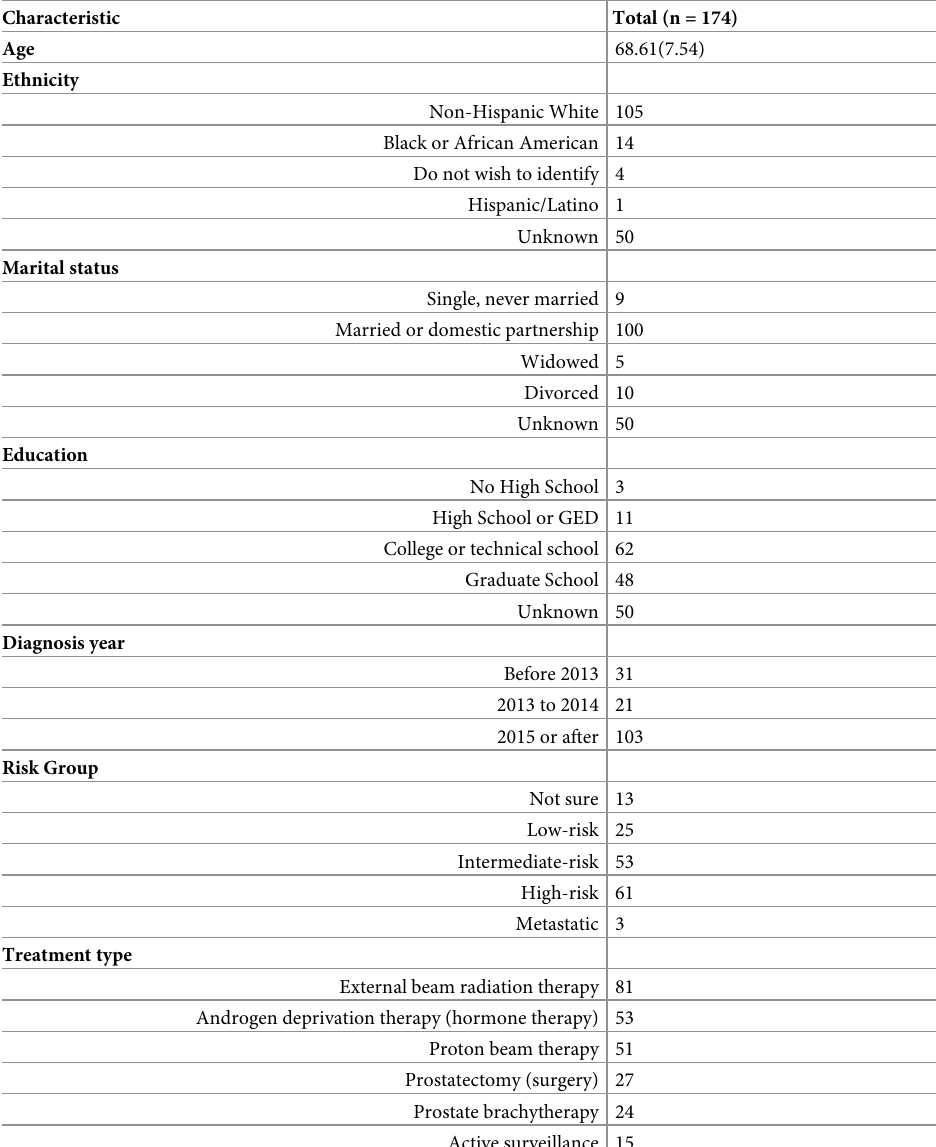
Table 1. Patient